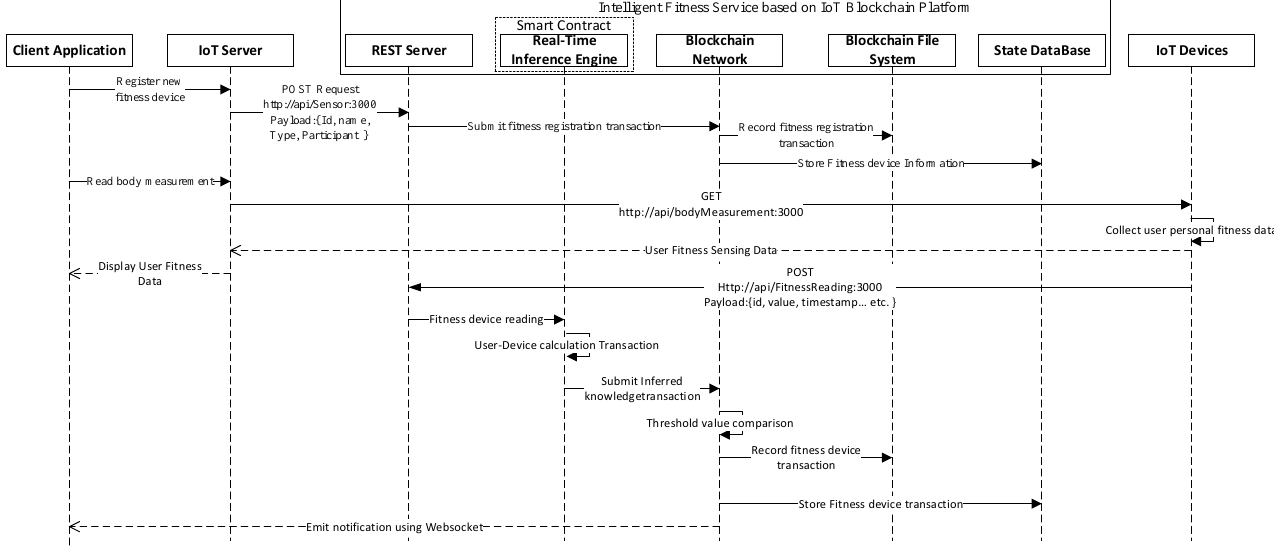
Figure 8. Intelligent smart contract based real-time inference